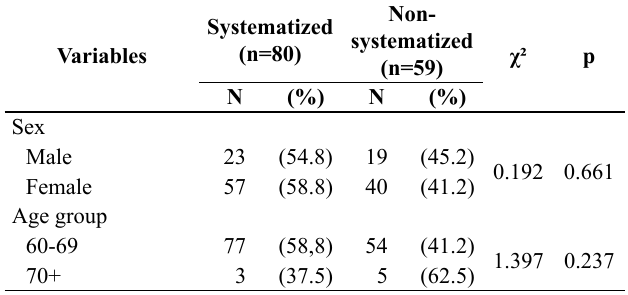
Table 1. Comparison of the proportions of elderly practitioners and non-practitioners of systematized physical exercises according to so- ciodemographic